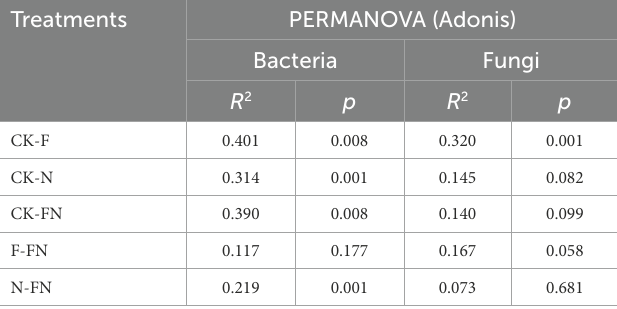
TABLE 2 Differences in microbial β diversity among different treatments. Treatments